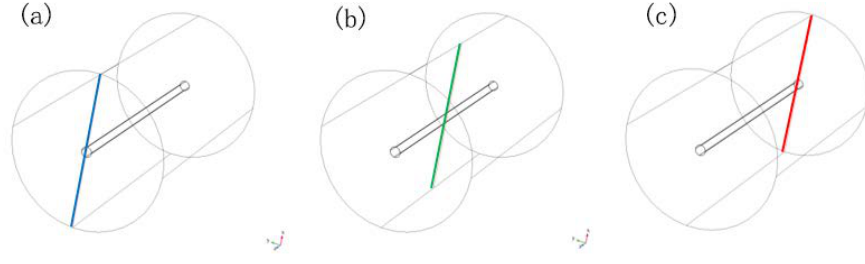
Figure 11. Standard linear position map for material temperature statistics: ( a ) entrance; ( b ) center; ( c ) exit.